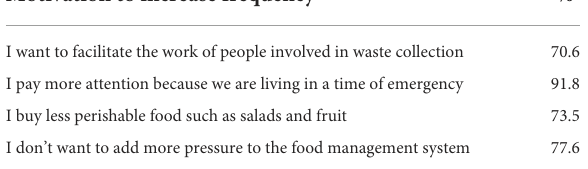
TABLE 11 Summary statistics of the main reasons for the decrease in the amount of food wasted and thrown